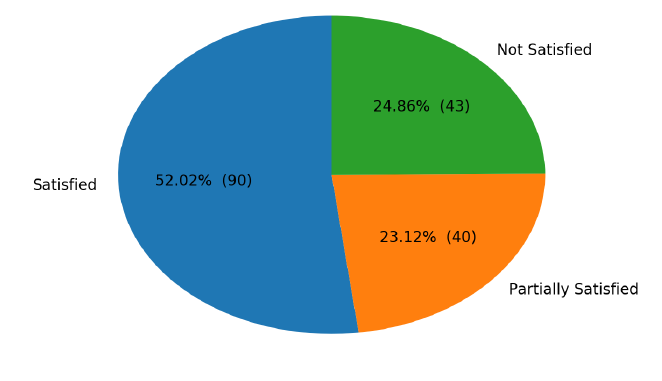
Figure 18. Proportions of the three highlight generation performance categories: satisfied, partially satisfied, and not